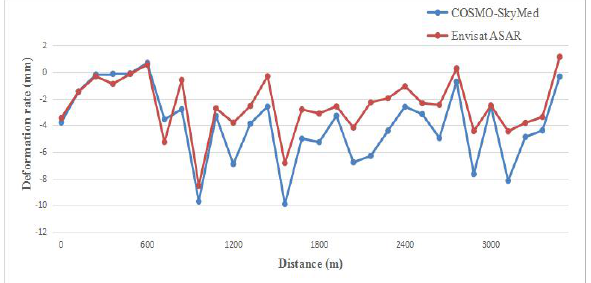
Figure 7. The displacement rate in the vertical direction